Question: Provide a one-line summary of what is displayed.
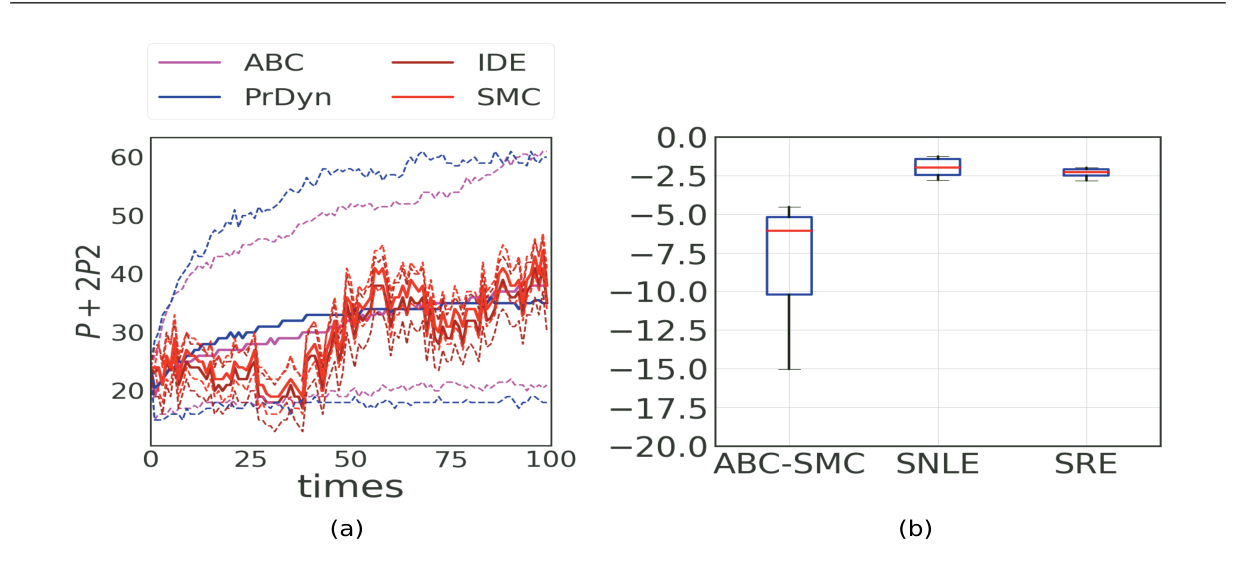
Answer: (a) Posterior distributions of the latent sample path x summarised by the mean (solid lines) and 95% credible intervals (broken lines), for the Prokaryotic autoregulator. The ABC-SMC is using the full dataset. (b) Accuracy of parameter estimates for the Prokaryotic autoregulator model, evaluated using the log probability of the true generative parameter vector, summarised across the 10 datasets. SRE and ABC-SMC is using the full dataset.